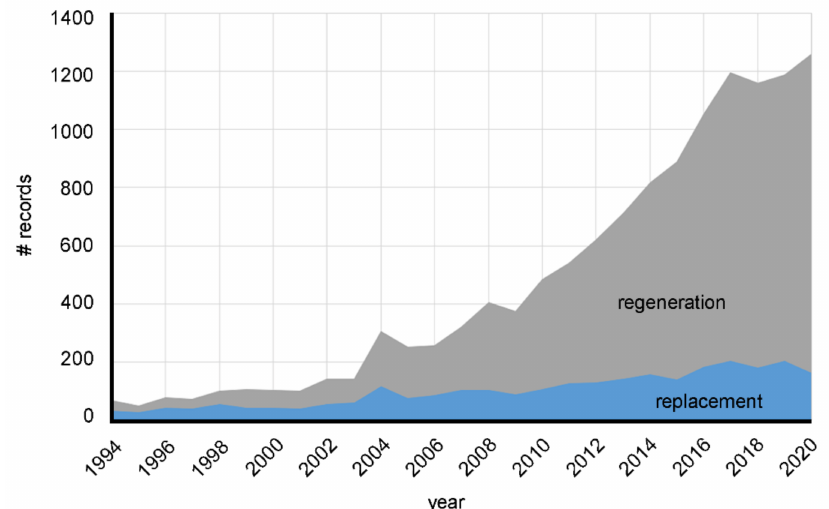
Figure 2. Trend in the number of Scopus records from 1994 to 2020 for the keywords “biomaterials replacement” and “biomaterials regeneration”.